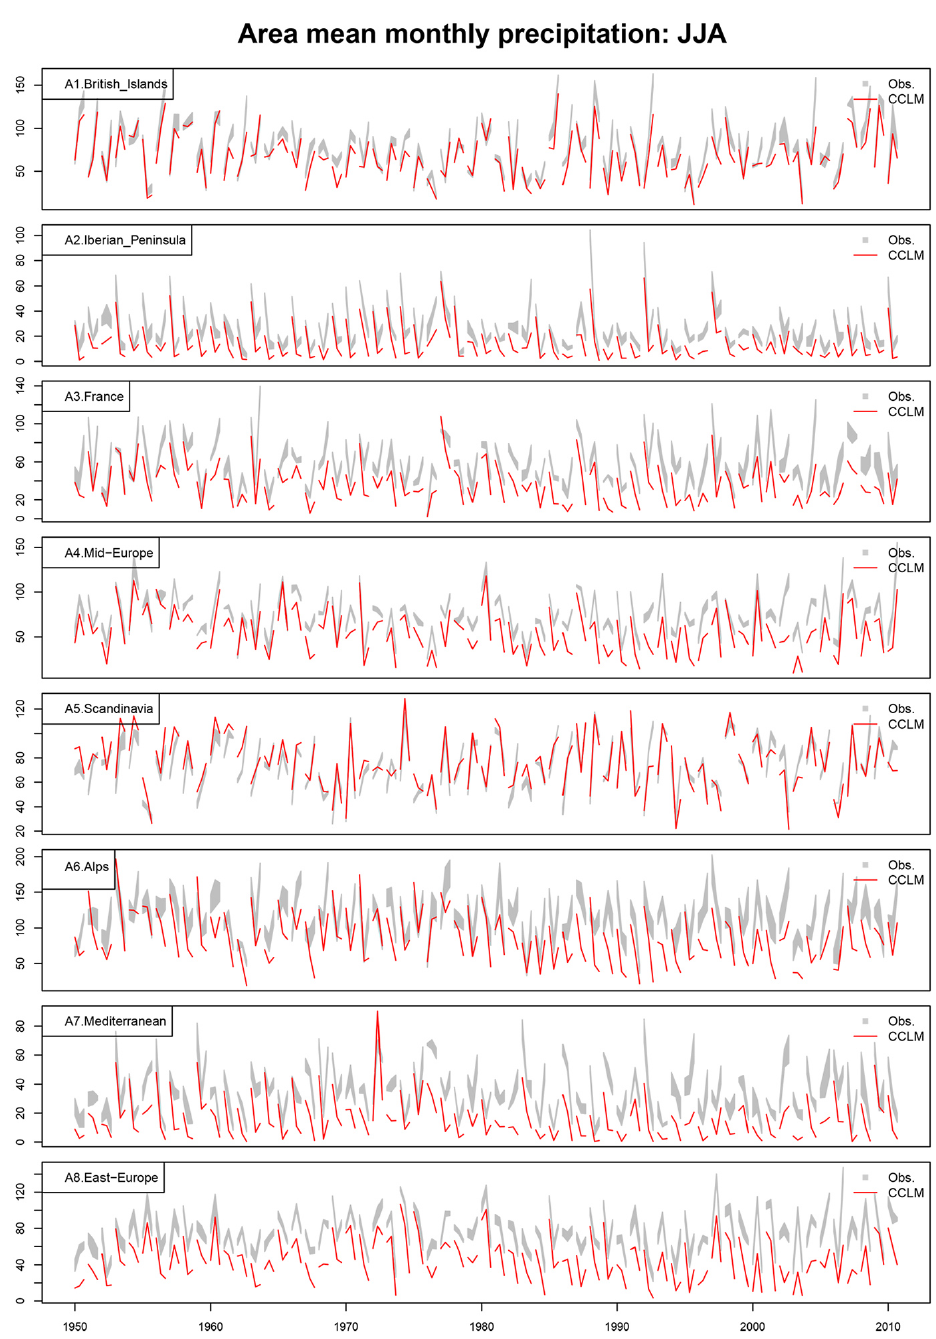
Figure 8c. Area mean monthly sums of total precipitation of June, July, and August of 1950–2010: coastDat2-CCLM (red), range of GPCC6, E-OBS8.0 and CRU3.2 for each season (gray